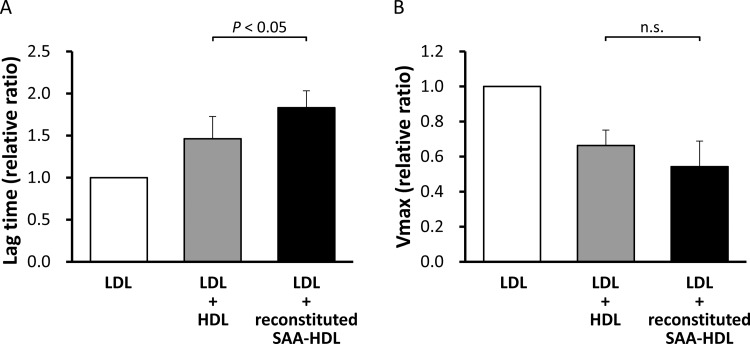
Antioxidant ability of reconstituted SAA-HDL and normal HDLHDLs obtained from healthy subjects (final HDL-Cho of 25 mg/dl) were incubated with or without rhSAA (final concentration of 1 mg/ml) for 60 min at room temperature. The mixtures were then ultracentrifuged at the density of 1.210 g/ml to remove unattached SAA. HDLs in top fractions were defined as reconstituted SAA-HDL (incubated with rhSAA) and normal HDL (incubated without rhSAA). Antioxidant abilities of both HDLs were determined as described in the ‘Materials and Methods’ section. The values were expressed as the mean of lag time (A) and Vmax (B) relative to those of LDL alone, defined as 1. Bars represent S.D. from four separate experiments. n.s., not significant.